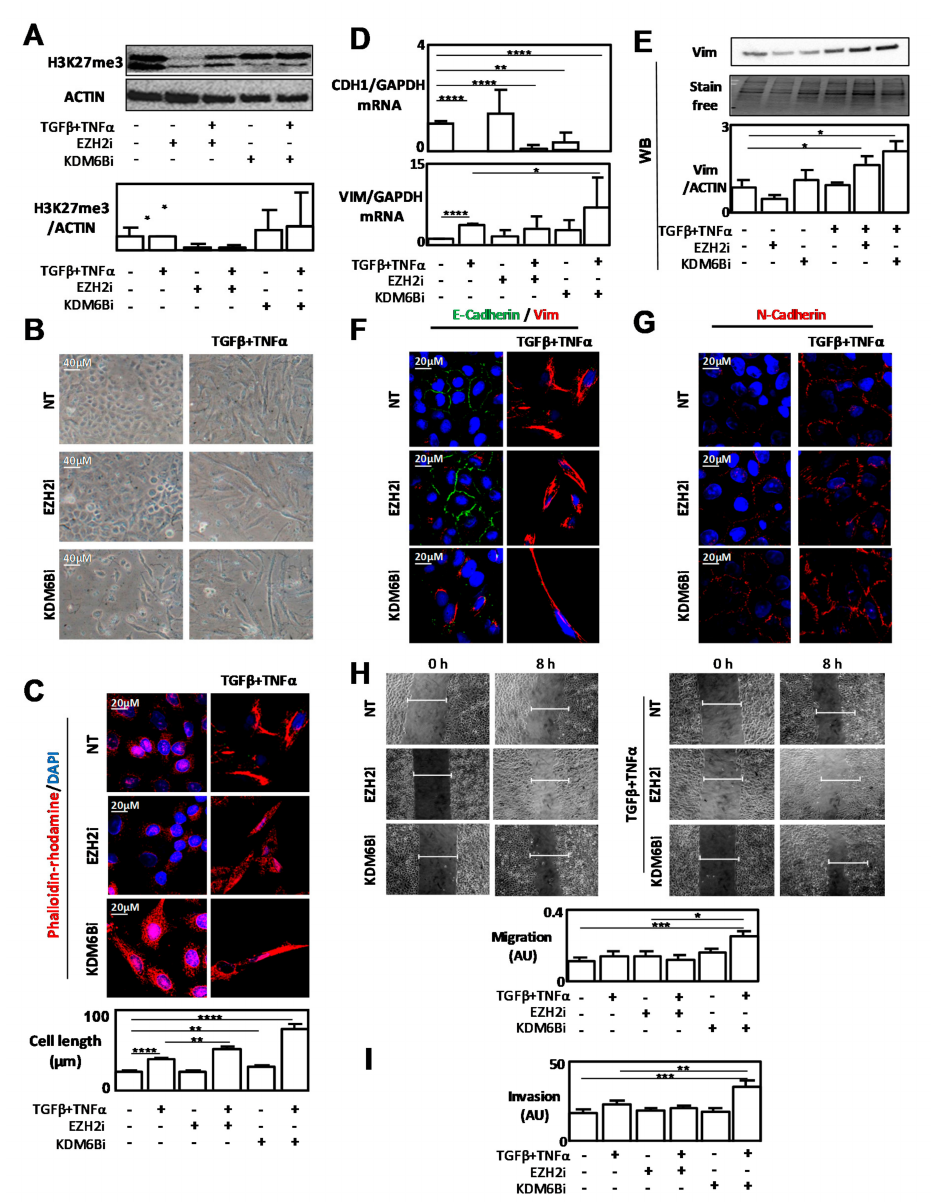
Figure 3. Inhibition of EZH2 and KDM6B activities using specific inhibitors favored EMT-like phenotypes. ( A ) Quantification of H3K27me3 levels using WB in A549 cells treated with TGF β / TNF α and / or EZH2i. ( B ) Representative phenotype of A549 cells treated with TGF β / TNF α and / or EZH2i or KDM6Bi (EVOS ™ 10 × Objective). ( C ) Phalloidin-rhodamin staining of A549 cells treated with TGF β / TNF α and / or EZH2i or KDM6Bi. ( D ) Quantification of CDH1 and Vimentin expression levels using RT-qPCR in A549 cells treated with TGF β / TNF α and / or EZH2i or KDM6Bi. ( E ) Quantification of Vimentin expression using WB in A549 cells treated with TGF β / TNF α and / or EZH2i or GSKJ4. ( F ) IF staining of E-Cadherin (green) and Vimentin (red) in A549 cells treated with TGF β / TNF α and / or EZH2i or KDM6Bi. ( G ) IF staining of N-Cadherin (red) in A549 cells treated with TGF β / TNF α and / or EZH2i or KDM6Bi. ( H ) Wound healing experiments in A549 cells treated with TGF β / TNF α and / or EZH2i or KDM6Bi and relative quantifications (EVOS ™ 4 × Objective). ( I ) Invasion tests in A549 cells treated with TGF β / TNF α and / or EZH2i or KDM6Bi. * = 0.01 < p < 0.05; ** = 0.005 < p < 0.01; *** = 0.001 < p < 0.005; **** = p <